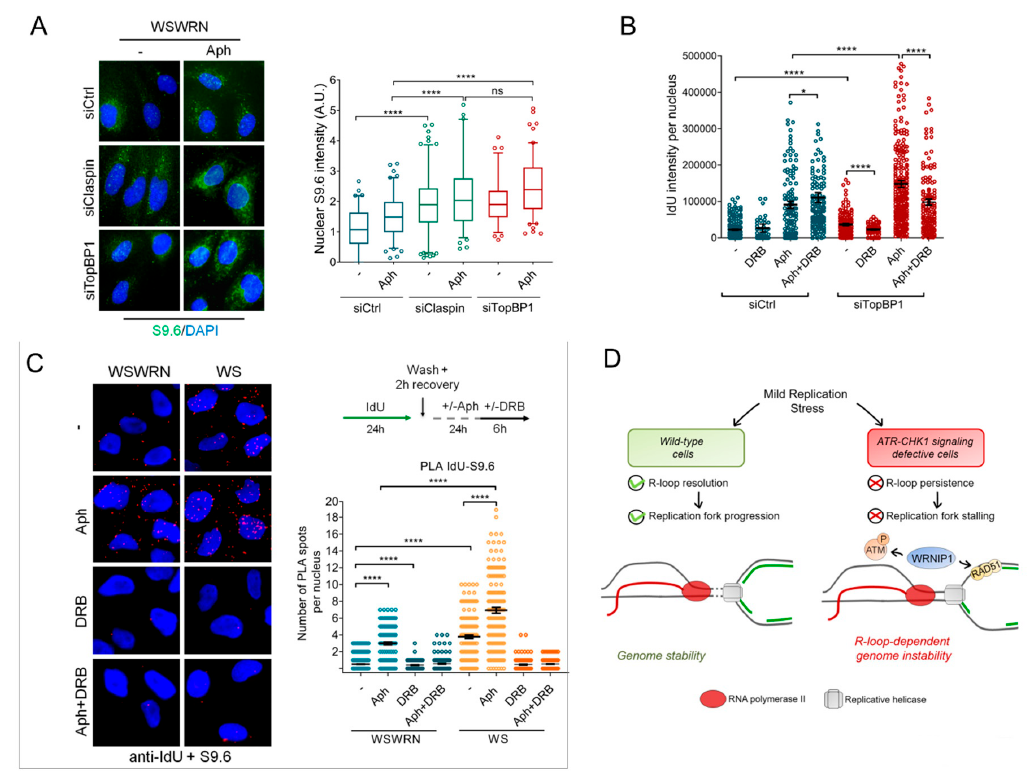
Figure 7. Spatial proximity between ssDNA and R-loops upon MRS in cells with dysfunctional ATR-dependent checkpoint. ( A ) Immunofluorescence detection of R-loops with S9.6 antibody in WSWRN cells transfected with GFP, Claspin, or TopBP1 siRNA and treated with 0.4 µ M Aph for 24 h. Box plot shows nuclear S9.6 fluorescence intensity. Box and whiskers represent 20–75 and 10–90 percentiles, respectively; ( B ) detection of ssDNA by IF with an anti-BrdU / IdU antibody in WSWRN transfected with GFP or TopBP1 siRNA and treated with 0.4 µ M Aph for 24 h. Graph shows the mean ± SE from three independent experiments; ( C ) analysis of proximity between ssDNA (anti-BrdU / IdU antibody) and R-loops (anti-S9.6 antibody) performed by in situ PLA assay in WSWRN cells transfected with GFP or TopBP1 siRNA and treated as reported in the scheme. PLA interaction is shown in red. Graph shows the number of PLA spots per nucleus; and ( D ) proposed model of a role of WRNIP1 in suppressing R-loop-induced genome instability in cells with dysfunctional ATR-mediated checkpoint.